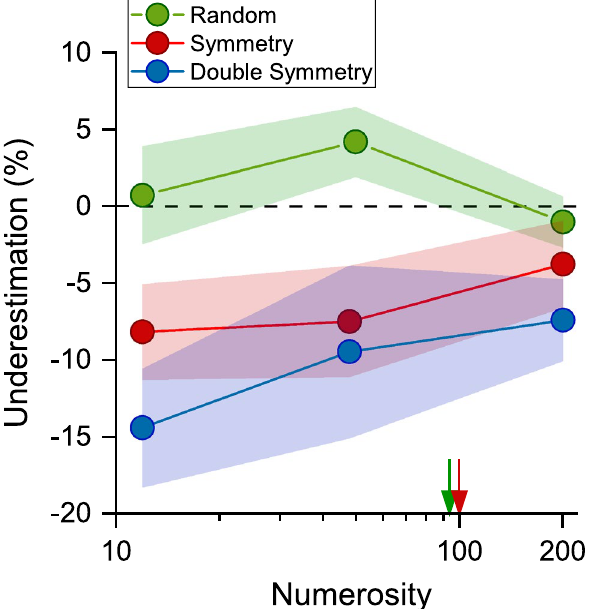
Figure 4. Bias for random, vertical symmetry and double symmetry conditions. Average bias for random (green circles), vertical symmetry (red squares) and double symmetry (blue circles) stimuli as a function of numerosity. Arrows indicate the switching point from the estimation to the density regime for random (green) and vertical symmetry (red) conditions. Shaded areas represent 95% confidence interval.